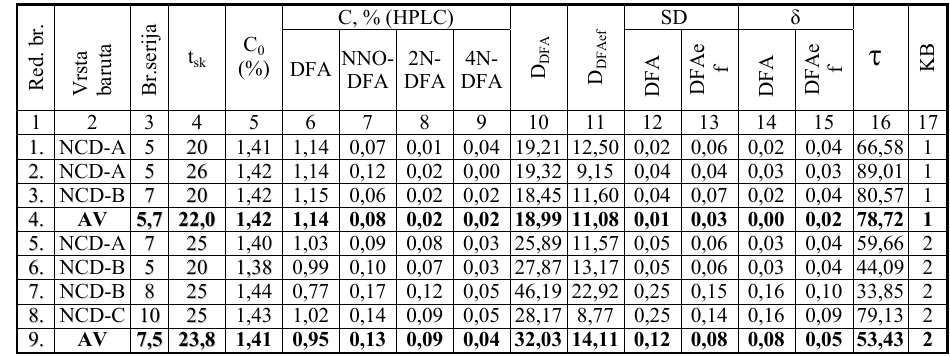
Rezultati ispitivanja sadržaja stabilizatora NCD baruta